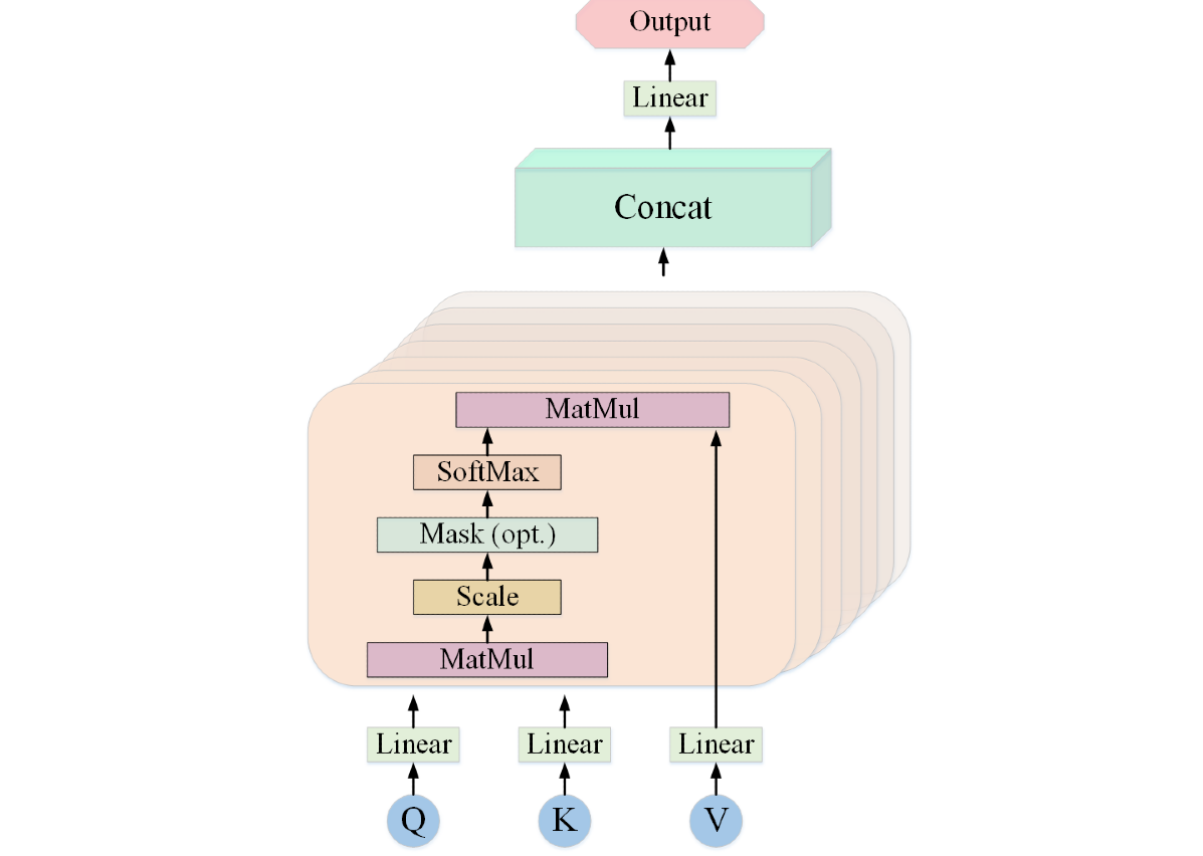
Figure 3. Multi-head attention mechanism. K: key; Q: query; V: